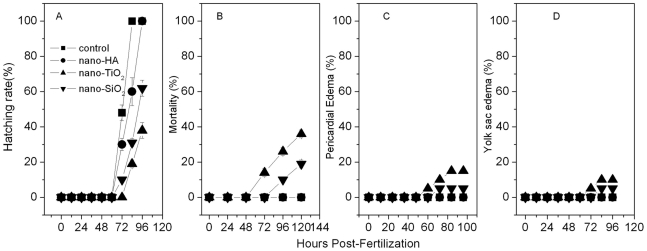
Toxicity-causing rate of Zebrafish embryos and larvae.A: Hatching rate, B: Mortality, C: PE and D: YSE. Exposed in 100 mg/L nano-HA, 100 mg/L nano-TiO2 and 100 mg/L nano-SiO2.